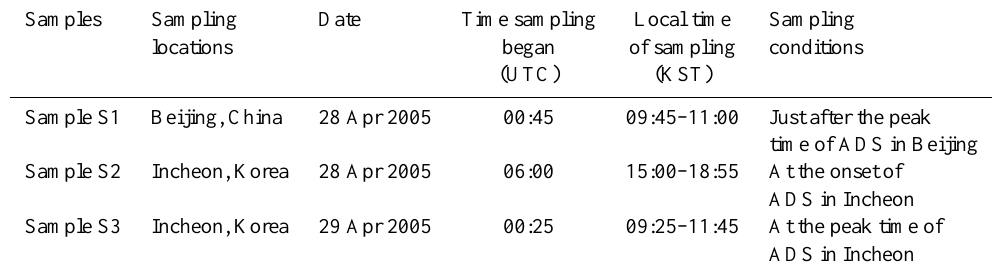
Table 1. Sampling locations, dates and